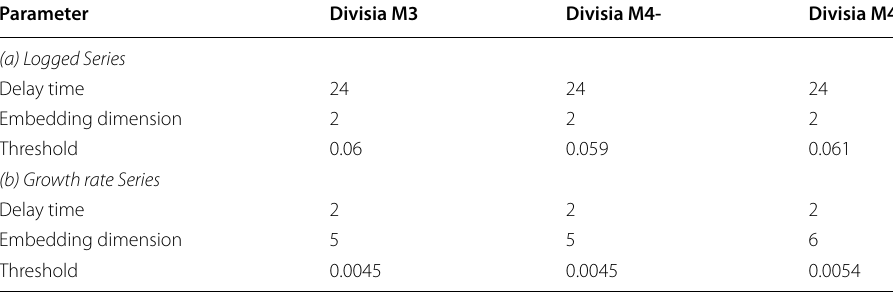
Table 1 Parameter values for the constructions of RPs of narrow aggregates Parameter M1 M2 M2M MZM ALL Delay time Embedding dimension Threshold 0.075 Delay time Embedding dimension Threshold